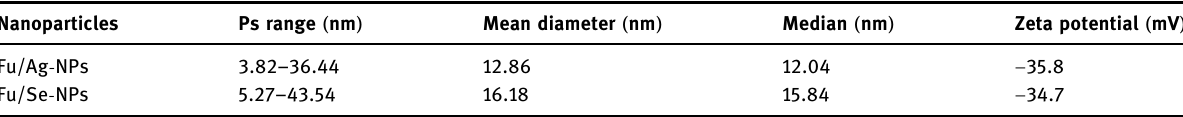
Table 3: Particle size ( Ps ) distribution and ζ potential of Fu - synthesized Ag - NPs and Se - NPs